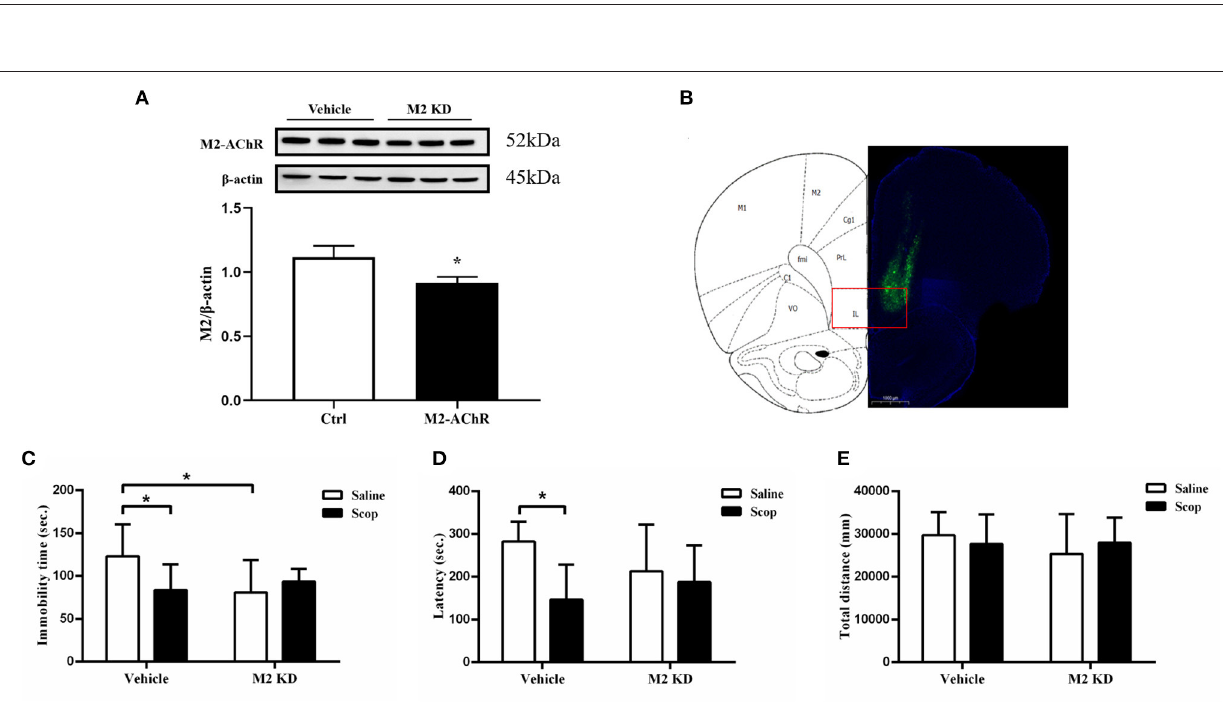
FIGURE 4 | (A) Expression of M2-AChR in the M2-KD group was significantly reduced. (B) location of frozen section needle path, showing that AAV-CHRM2-shRNA (pAAV-U6-shRNA (Chrm2)-CMV-EGFP-pA) was injected into the mPFC. (C) immobility time of the M2-KD-saline group and Ctrl-scop group is significantly reduced. (D) latency of the Ctrl + saline group in NSFT is significantly reduced. (E) total distance between these groups shows no significant difference. n = 7–9/group; Crtl: control; Scop: scopolamine; *: p <